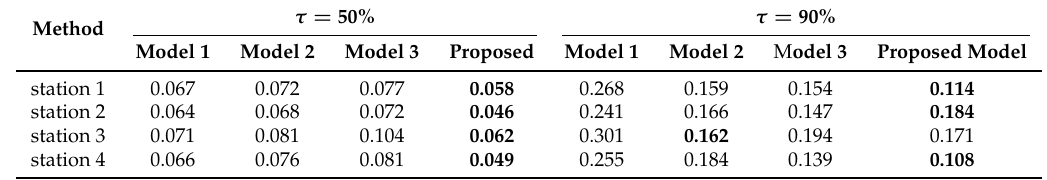
Table 2. Performance comparison of the methods under 50%/90% coverage.